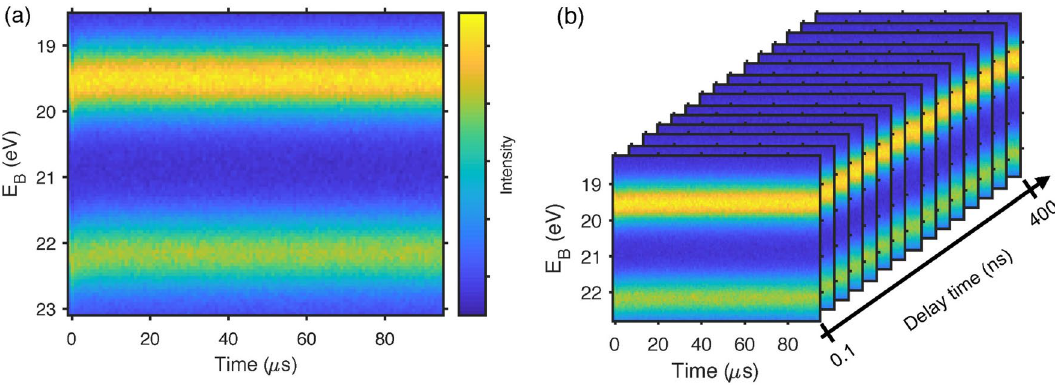
Figure 5. Visualisation of the data obtained in TRPES measurements: ( a ) Trigger time map of the Pb 5d core level measured at a delay time of 122 ns for a 250 nm thick PbS quantum dot sample with a laser pulse energy of